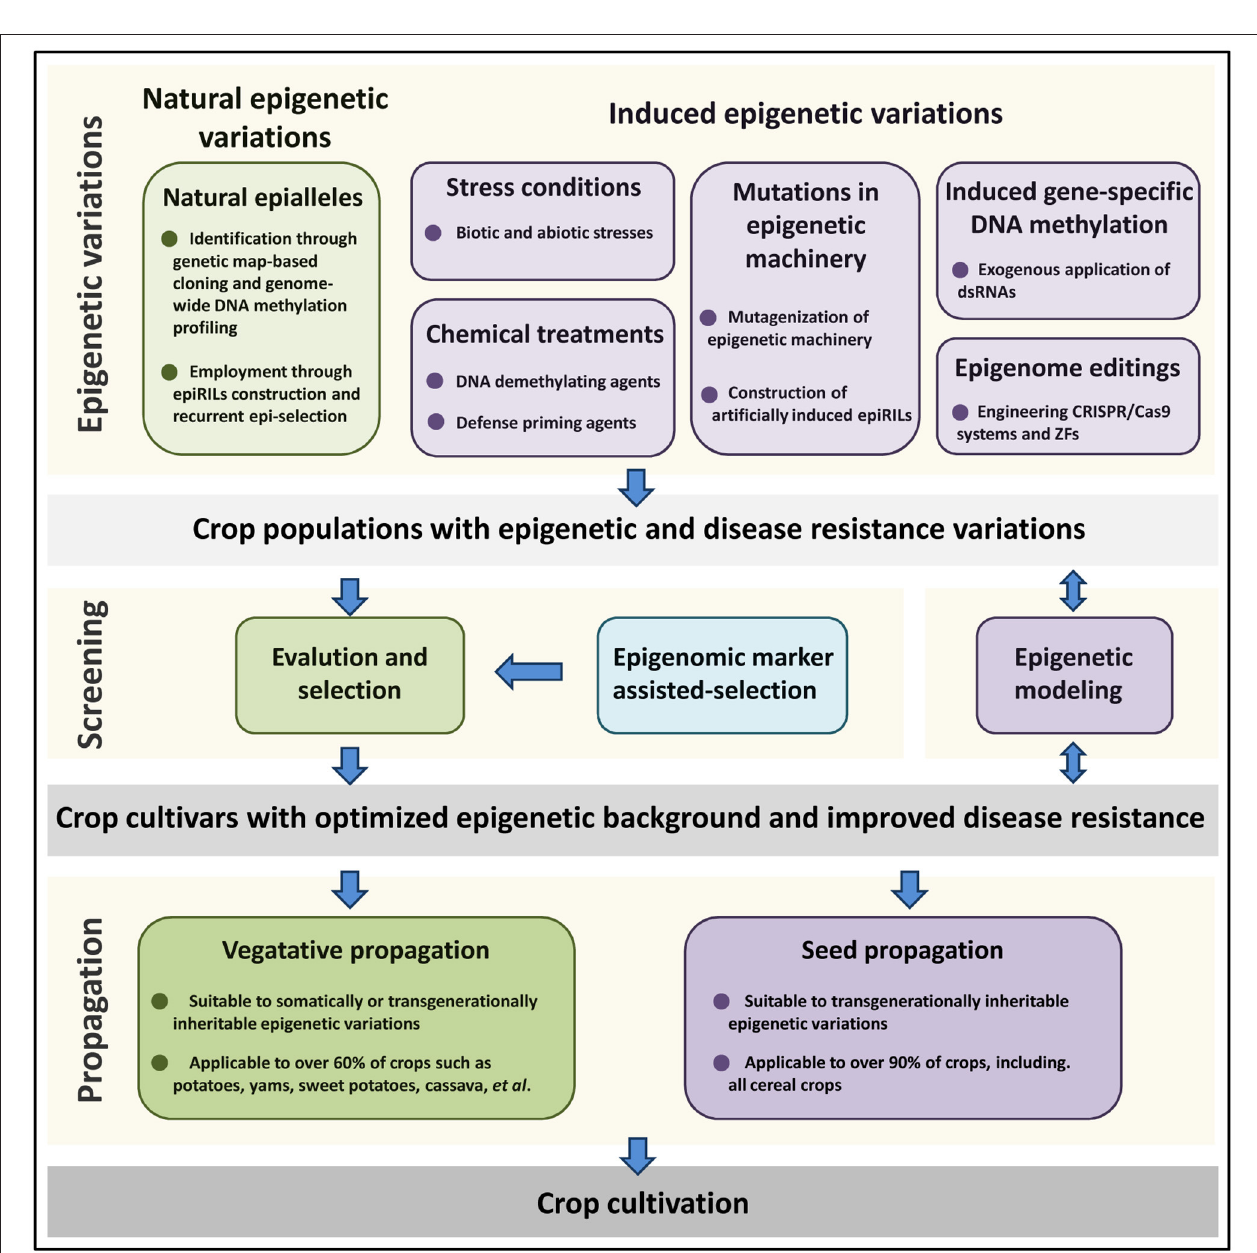
FIGURE 1 | Epi-breeding design for crop disease resistance improvement. Epigenetic variations are either derived from natural populations, or induced by stresses, chemical treatments, mutations in epigenetic machinery, induced gene-specific DNA methylation, and epigenome editings. After epigenetic variations have been generated, crop variants with improved disease resistance are chosen and propagated. DNA methylation marks can be transgenerationally inherited and suitable for epi-breeding in all kinds of crops. However, histone post-translational modifications are only relevant to epi-breeding in clonally propagated crops. Epigenomic variations such as DMRs related to disease resistance traits could be employed as molecular epigenomic markers to assist the evaluation and selection process. In addition, epigenetic modeling could be used to predict the effect of epigenetic variations on crop disease resistance and provide instruction for crop epi-breeding